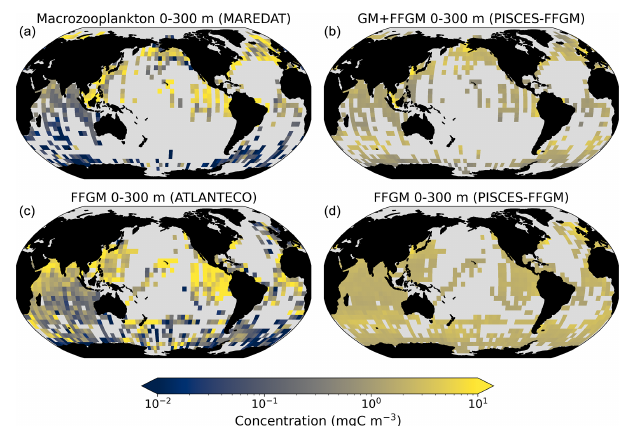
Figure 4. Comparison between observed and modeled macro- zooplankton biomasses. Annual means of carbon concentrations (mgCm − 3 , log scale) averaged over the top 300m on a 5 ◦ reso- lution grid. (a) Macrozooplankton from MAREDAT; (b) “model- sampled” total macrozooplankton (GM + FFGM); (c) FFGM from AtlantECO climatology; (d) “model-sampled” FFGM. As de- scribed in Sect. 2.4.3, modeled biomasses were sampled where ob- servations were